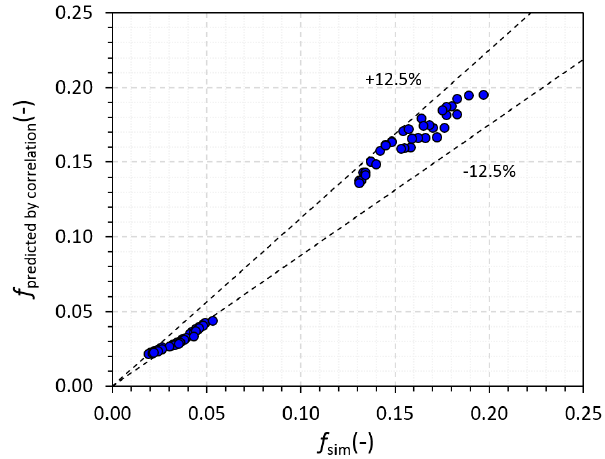
Figure 20. Comparison of simulation and predicted values of friction factor.